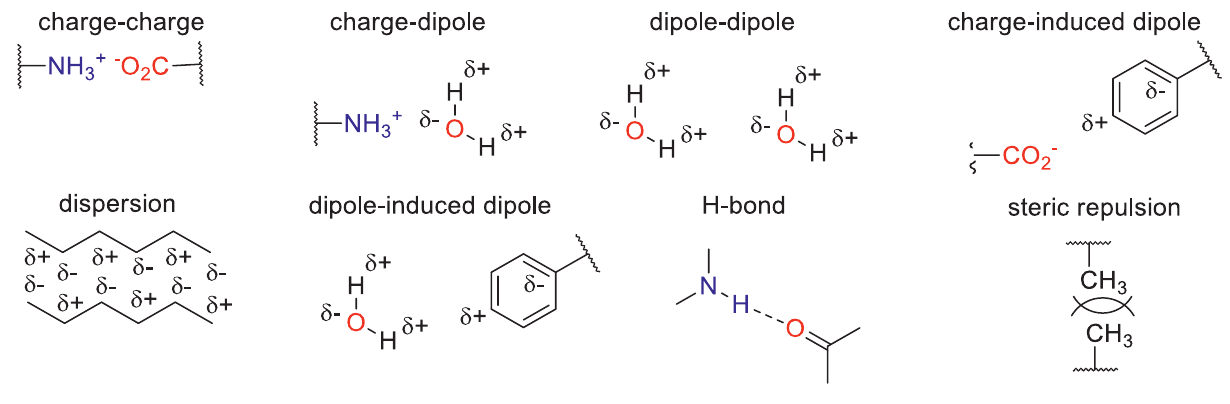
Figure 9 . Possible non-covalent interactions, see Ref.